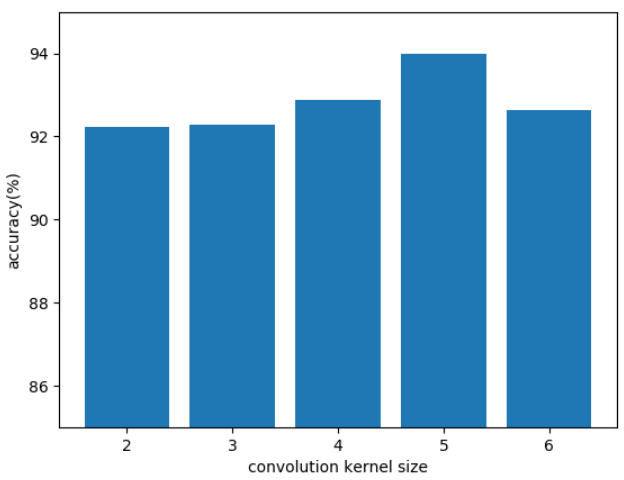
Figure 4. Model accuracy based on different convolution kernel sizes.